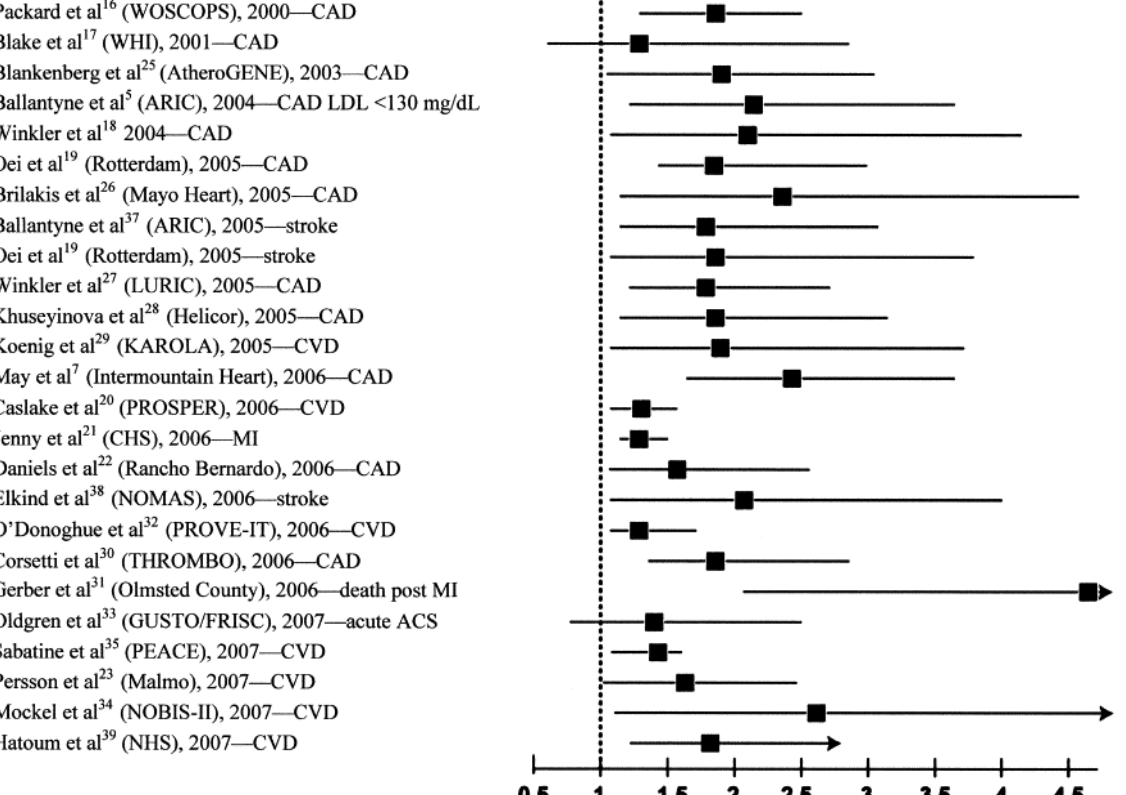
Figure 2. Elevated lipoprotein-associated phospholipase A2 (Lp-PLA2) is consistently associated with a doubling of risk for cardiovascular disease